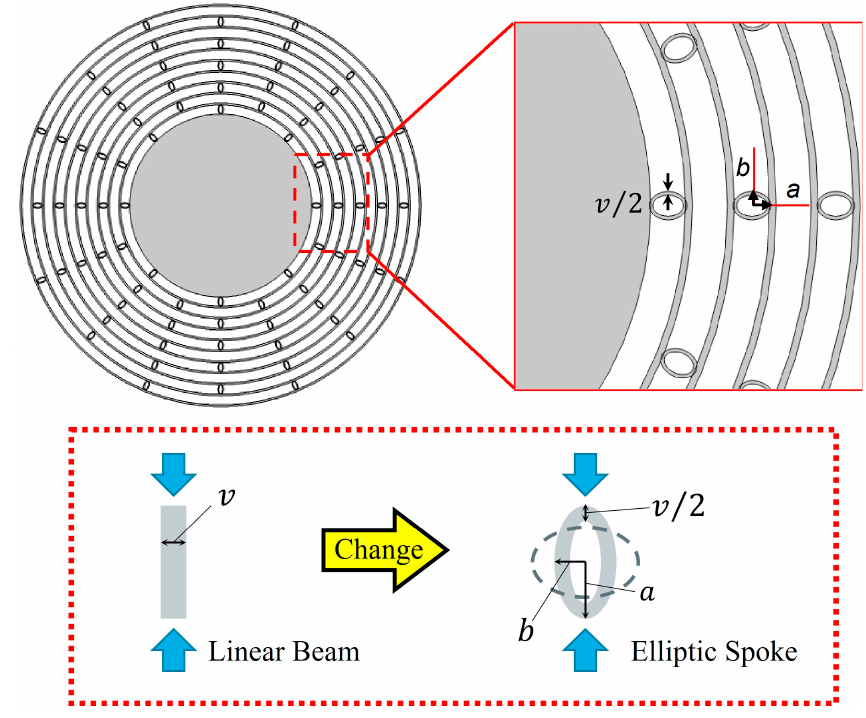
Figure 3. Schematic and some key parameters of elliptical spoke resonator.